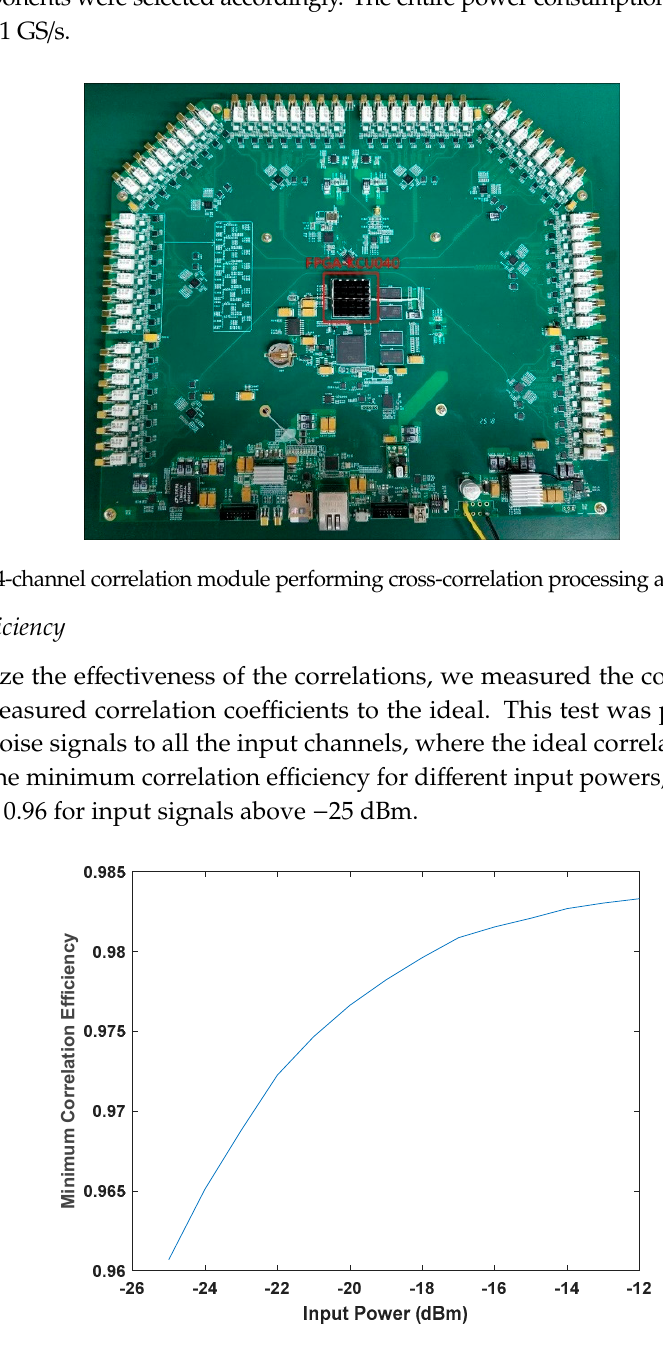
Figure 11. Schematic for power detection .